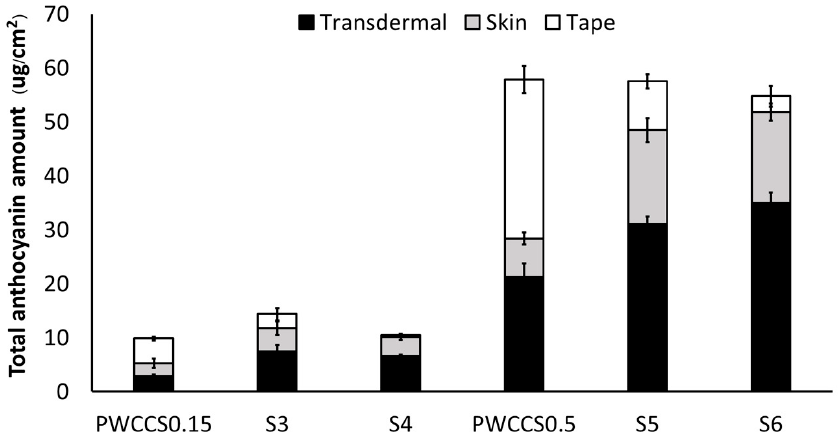
Figure 3. Amount of anthocyanin in the stratum corneum (tape), epidermis and dermis without the stratum corneum (skin), and permeated through the skin (transdermal) of porcine skin treated with 0.15% PWCCS (PWCCS0.15), 0.5% PWCCS (PWCCS0.5), or sericin hydrogels S3–S6, in PBS pH 5.5.